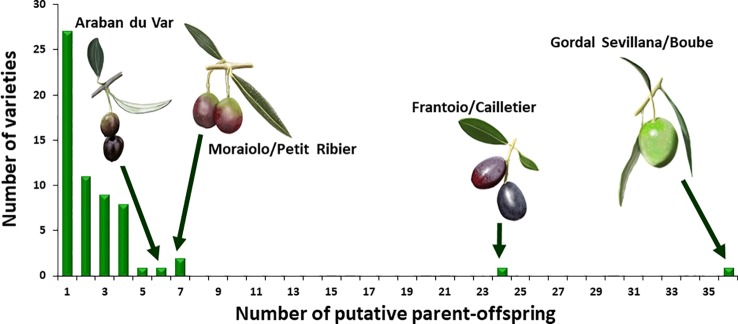
Histogram of the number of putative parents-offsprings observed for French varieties.